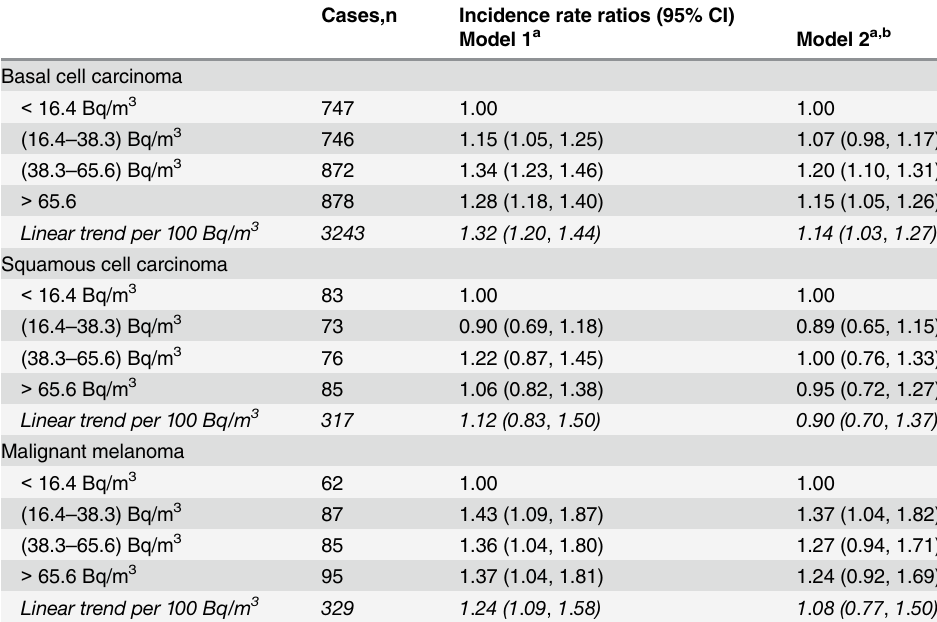
Table 2. Association between time-weighted average radon exposure # and basal cell carcinoma, squamous cell carcinoma and malignant melanoma among 51,445 Diet Cancer Health cohort